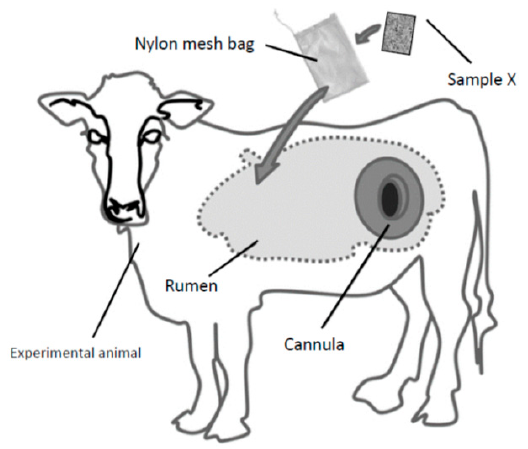
Figure 2. Schematic image of the in situ nylon bag technique (adapted from Berean et al., 2015 [13]).